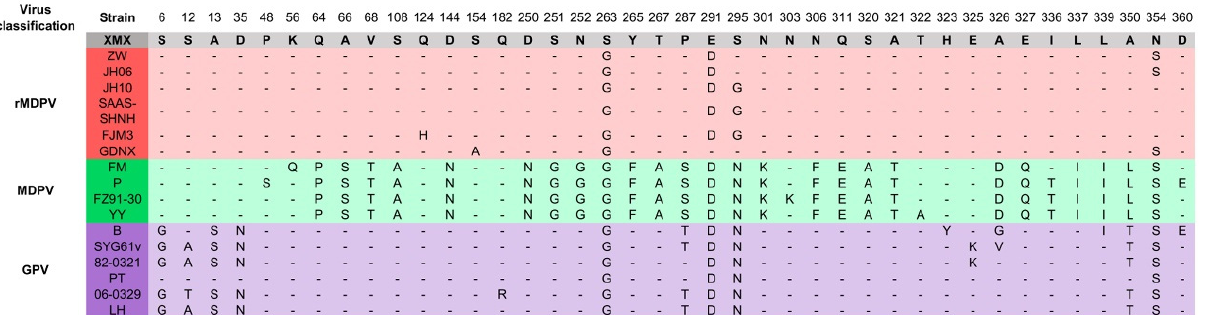
Figure 5. Phylogenetic analysis, based on complete MDPV and GPV genomic sequences on Gen- Bank. The phylogenetic tree was constructed via the neighbor-joining method using the Maximum Composite Likelihood method and 1000 bootstrap replicates. Accession numbers of strains are indicated in parentheses. The black origin represents rMDPV; the triangle represents the XMX strain. ( A ) Phylogenetic tree of complete genomic sequence; ( B ) Phylogenetic tree of REP sequence; ( C ) Phylogenetic tree of VP1 sequence; ( D ) Phylogenetic tree of ITR sequence.